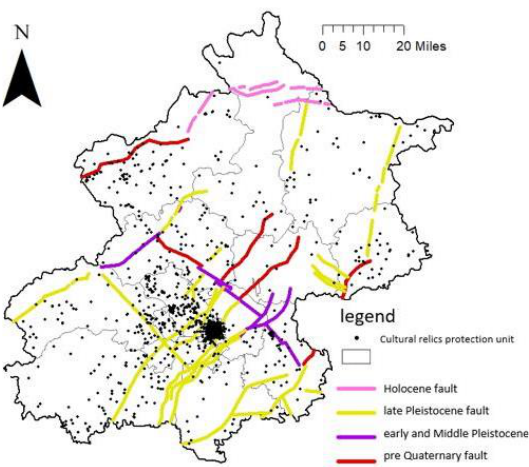
Figure 10. Distribution of seismic faults in cultural heritage units in Beijing.